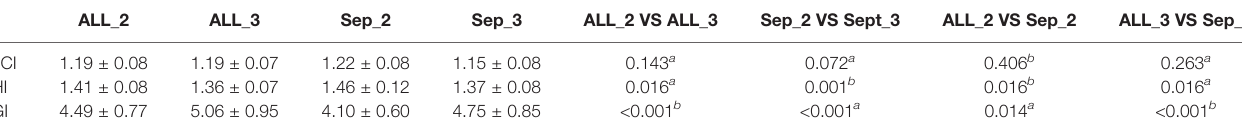
a Comparison by paired samples t-test. b Comparison by Wilcoxon signed-rank test.